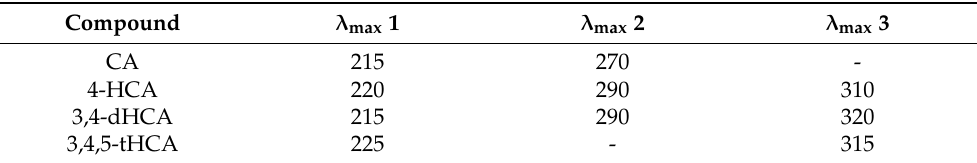
Figure 2. UV spectra of CA; 4-HCA; 3,4-dHCA; and 3,4,5-tHCA in methanol. Table 2. The wavelengths of maximum absorbance λ max [nm] from UV spectra of methanolic solutions of CA and its derivatives.